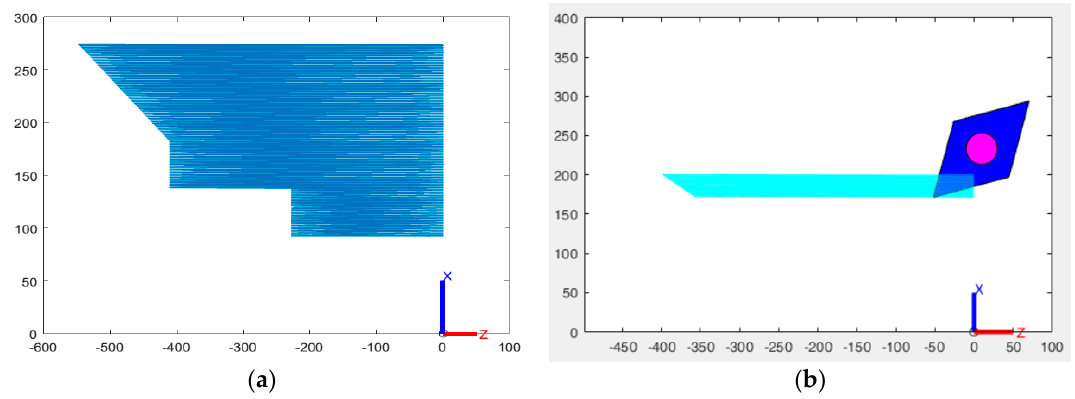
Figure 15. Simulation for the turning process using MATLAB script; ( a ) Path visualization for tool pass; ( b ) Simulation processes for turning operations.